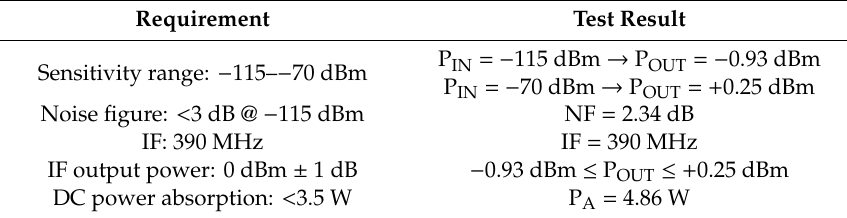
Table 1. Compliance of the receiver test results with the high-level